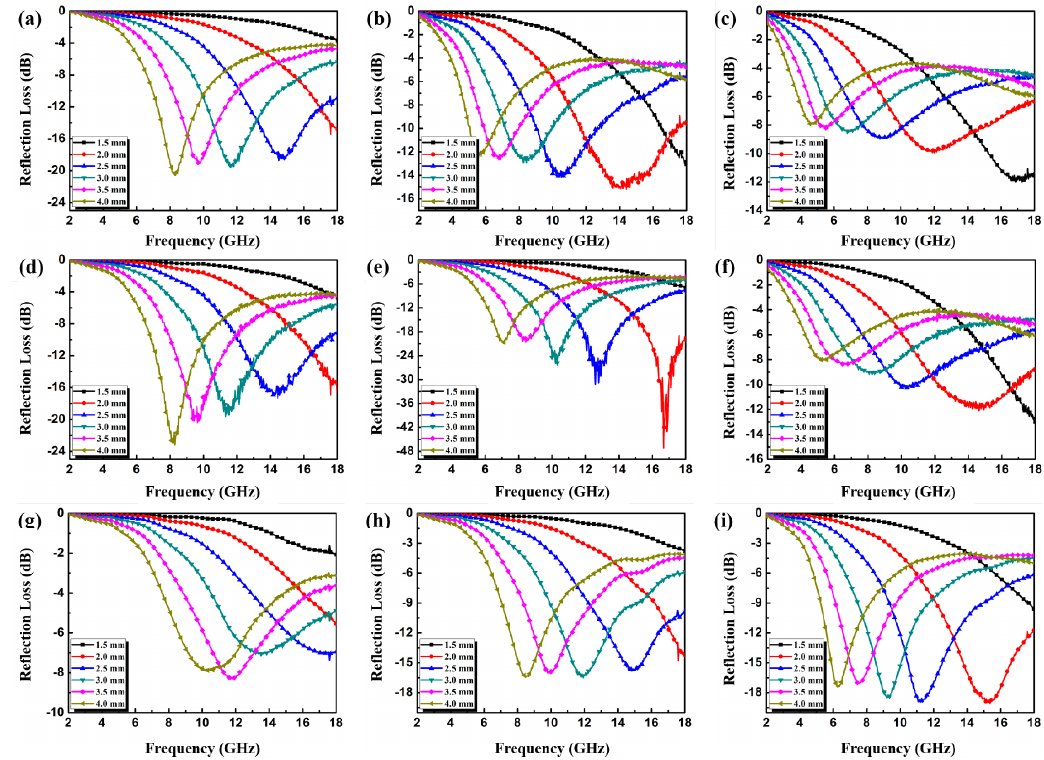
Figure 7. Reflection loss curves of sample A with filler loadings of 4 ( a ), 6 ( b ), and 8 wt% ( c ); sample B with filler loadings of 4 ( d ), 6 ( e ), and 8 wt% ( f ); and sample C with filler loadings of 4 ( g ), 6 ( h ), and 8 wt% ( i ).